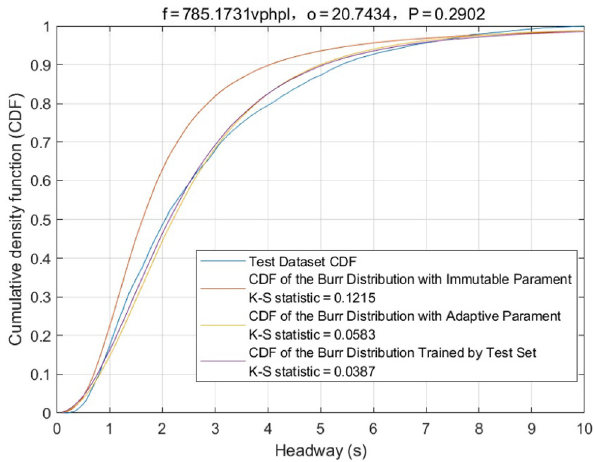
Figure 6 Comparison of different models